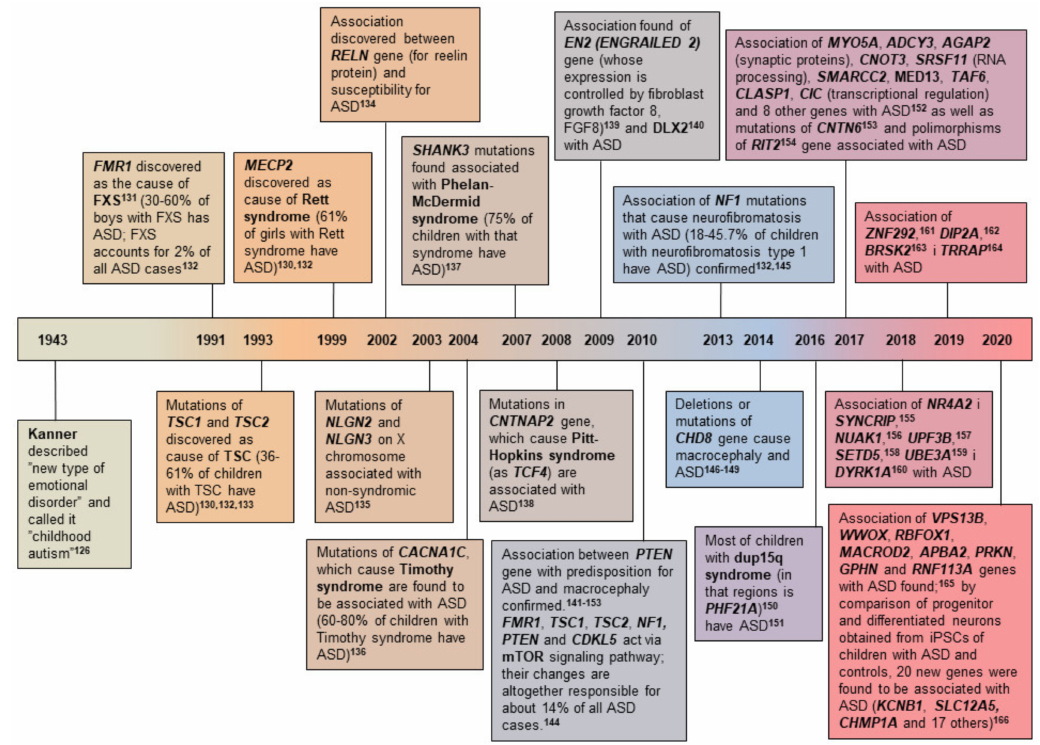
Figure 8. Time-lapse of major discoveries in regard to genes associated with autism spectrum disorder (ASD). FXS, Fragile X syndrome; iPSC, induced pluripotent stem cells; TSC, tuberous sclerosis complex. See text for